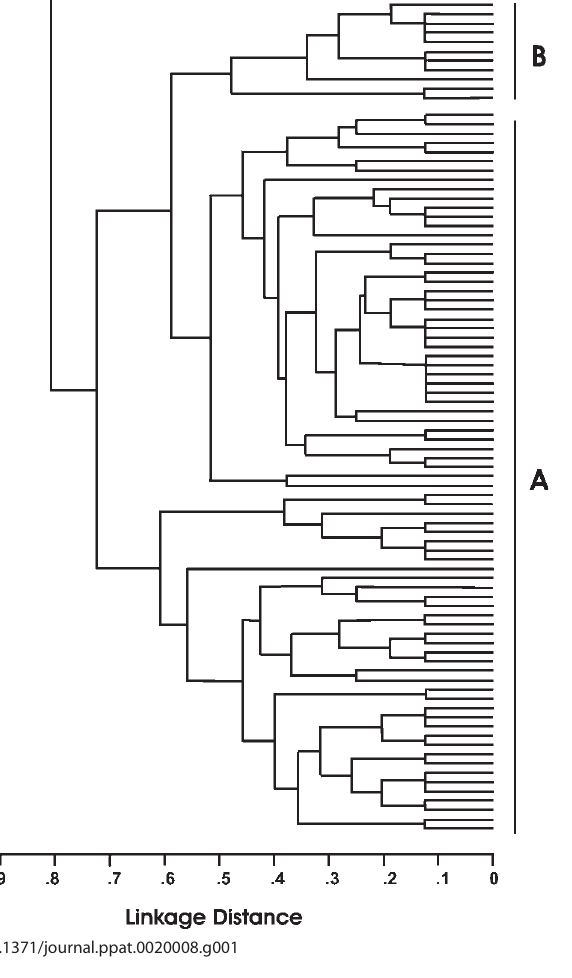
DOI: 10.1371/journal.ppat.0020008.g001 Figure 1. Multilocus VNTR-Analysis–Based Dendrogram Eight VNTR loci were analyzed following standard protocols [6]. The amplification products were analyzed by DNA sequencing and compared with 89 B. anthracis reference strains [4] processed with Sequence Type Analysis and Recombinational Tests (START) software (K. Jolley, University of Oxford). A, B. anthracis phylogenetic group A; B, B. anthracis phylogenetic group B [7]; F, the newly discovered B. anthracis group from sub-Saharan rainforests including the strains B. anthracis CI and